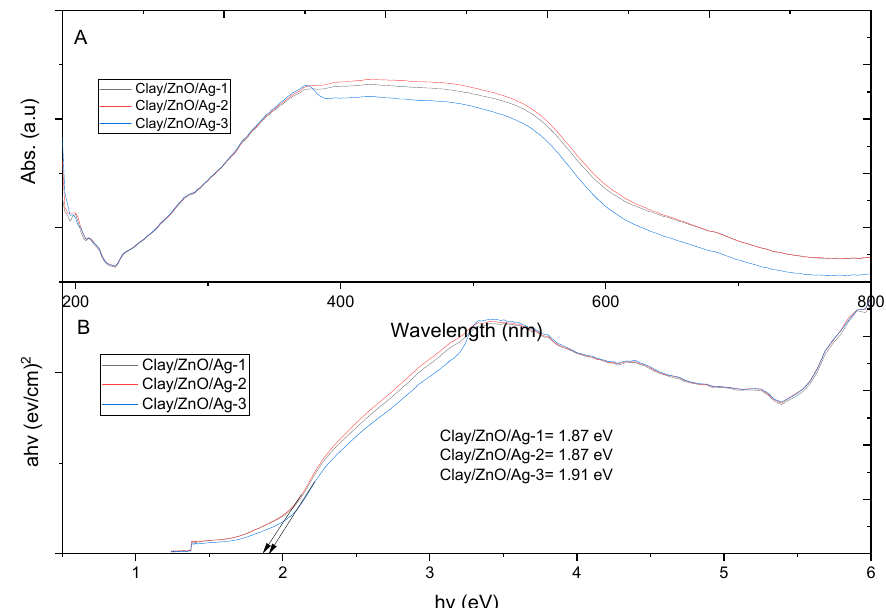
Figure 14. ( A ) UV–Vis spectrophotometric absorption spectra of clay / ZnO / Ag-1, clay / ZnO / Ag-2 and clay / ZnO / Ag-3 and ( B ) their respective band gap plots.